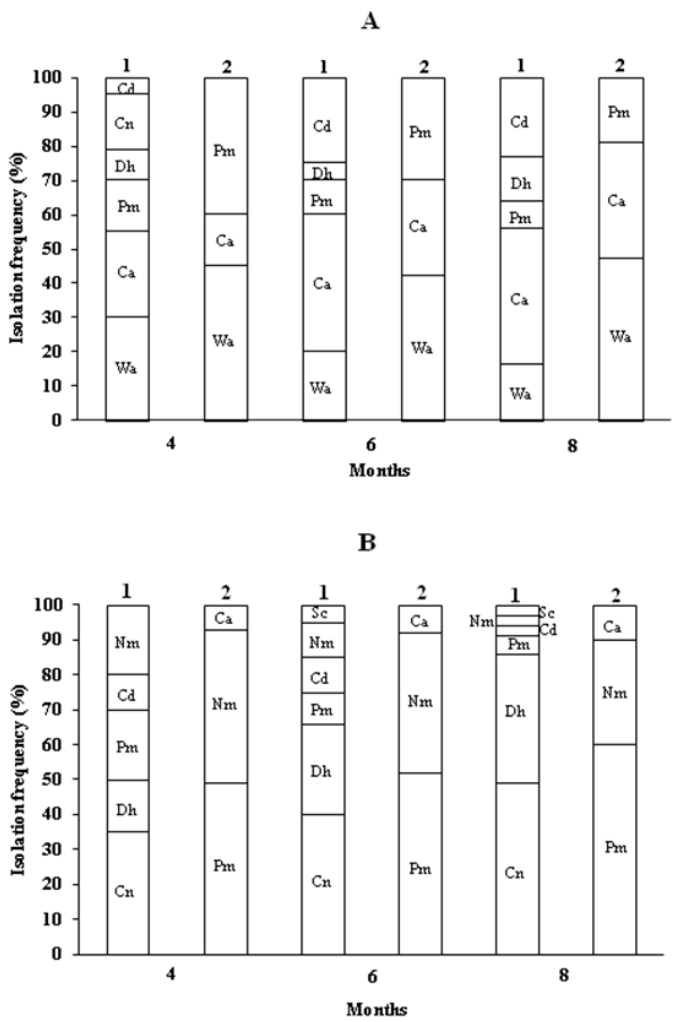
Figure 6. Isolation frequency of yeast species from brines of Leccino (A) and Taggiasca (B) black olives processed in modified (1) and unmodified (control) (2) industrial plastic barrels. Wa, W. anomalus ; Ca, C. adriatica ; Pm, P. manshurica ; Dh, D. hansenii ; Cn, C. norvegica ; Cd, C. diddensiae ; Nm, N. molendinolei ; and Sc, S. cerevisiae.